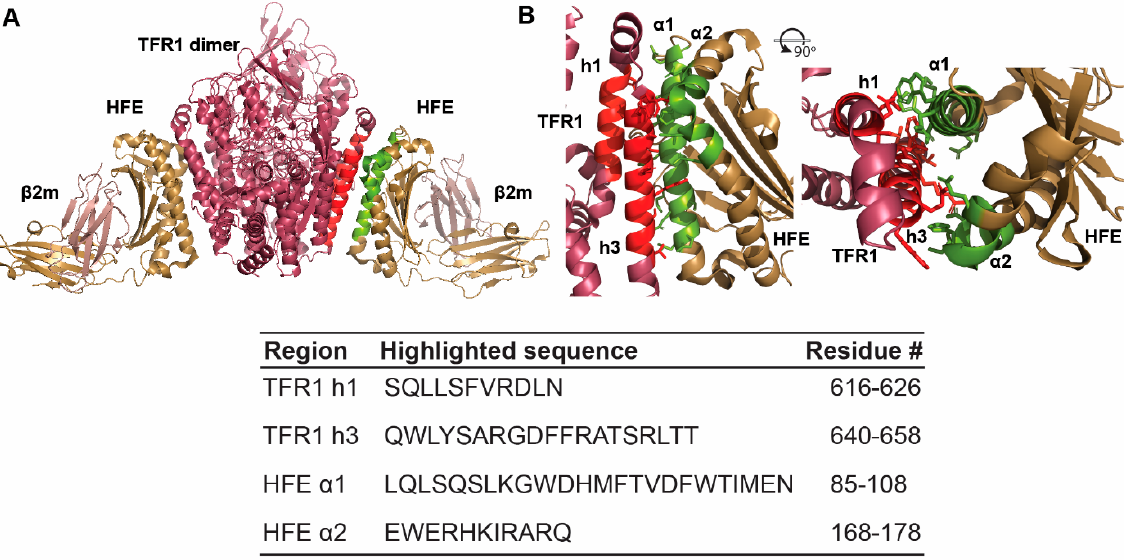
Figure 1. Crystal Structure of the HFE/TFR1 complex (PDB 1DE4). TFR1 is coloured in raspberry pink and HFE is coloured in sand yellow. ( A ) The full HFE/TFR1 complex and ( B ) the HFE/TFR1 interface. The complex interface involves the TFR1 three-helix bundle and HFE α -helical segments 1 and 2. The h1 and h3 correspond to the TFR1 helical segments 1 and 3, and α 1 and α 2 correspond to HFE α 1 and α 2 helices, respectively. The corresponding sequences and residue numbers for these regions are listed in the table. The interacting helical regions are coloured in red for TFR1 and in green for HFE.